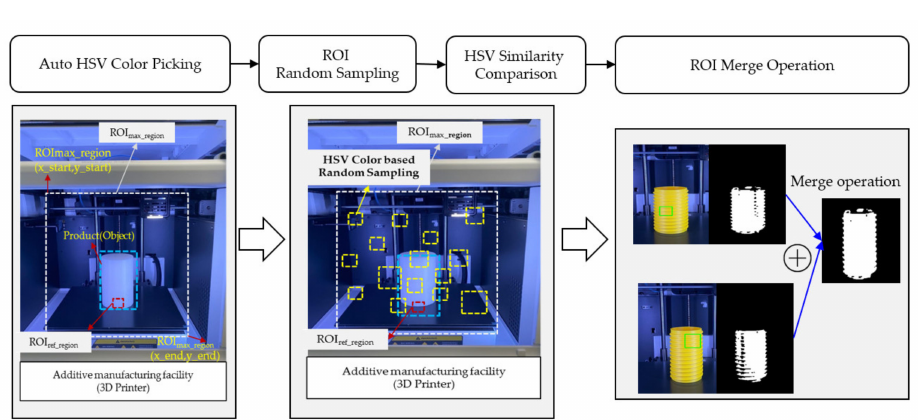
Figure 5. Process HSV color-space-based automated object localization algorithm. The process is described in Sections 4.2.1 and